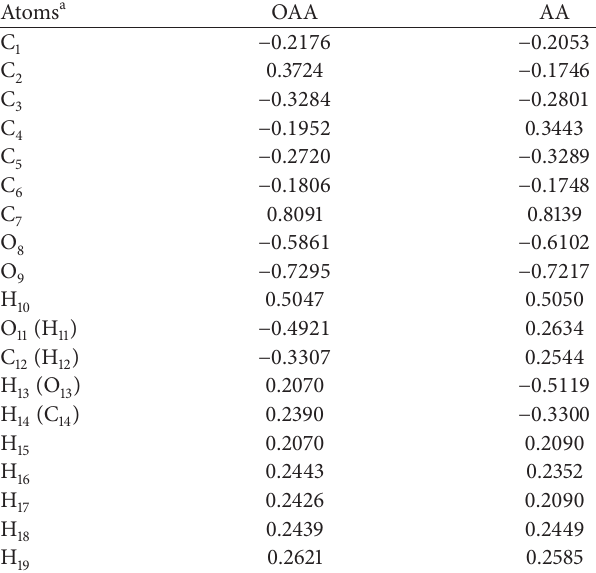
Table 13: Experimental and calculated 1 H NMR chemical shifts (ppm) of O-Anisic acid (OAA) and Anisic acid (AA). Exp B3LYP/6-31G Proton a